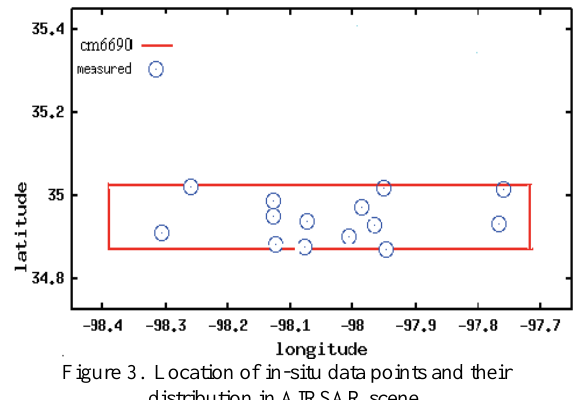
Figure 3. Location of in-situ data points and their distribution in AIRSAR